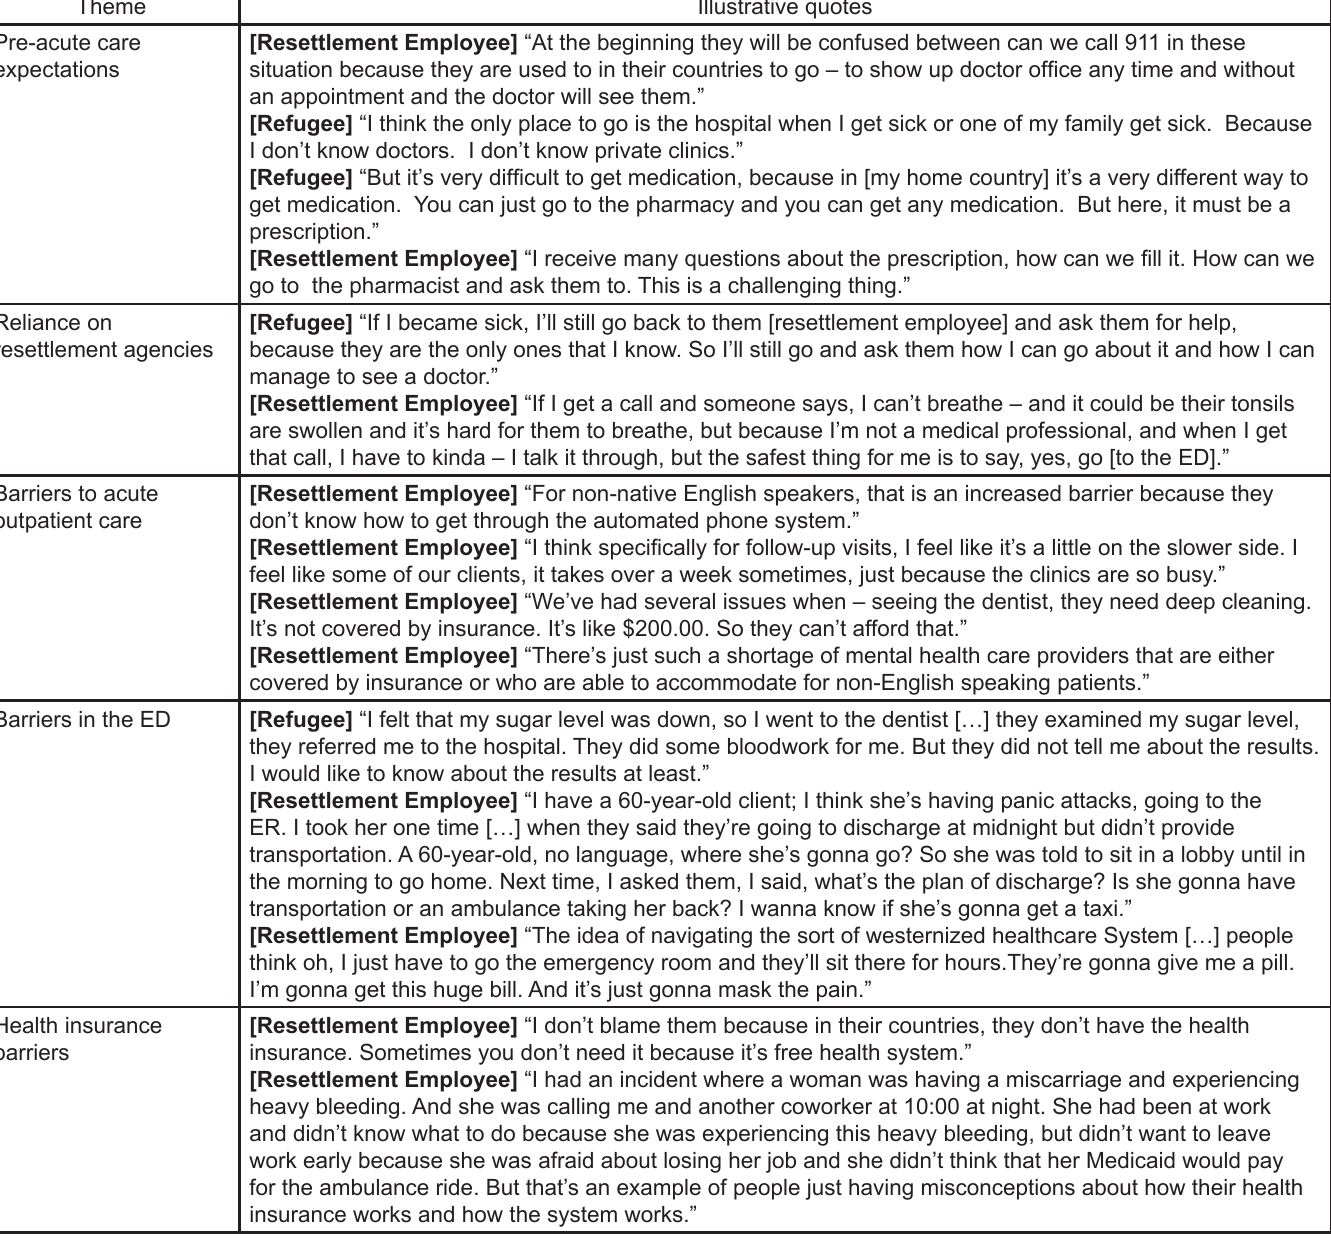
Table 1. Themes & Illustrative